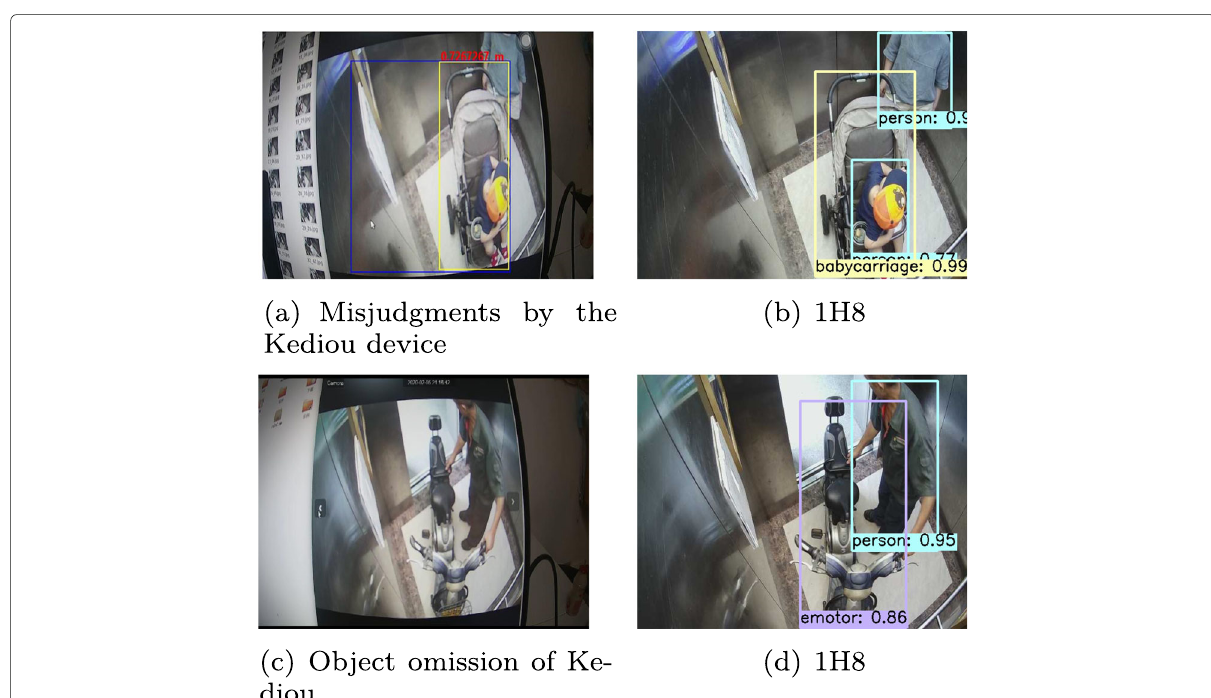
Fig. 13 Comparison of misjudgments by the a Kediou and b 1H8 systems, as well as the comparison of the objects omitted by the c Kediou and d 1H8 systems